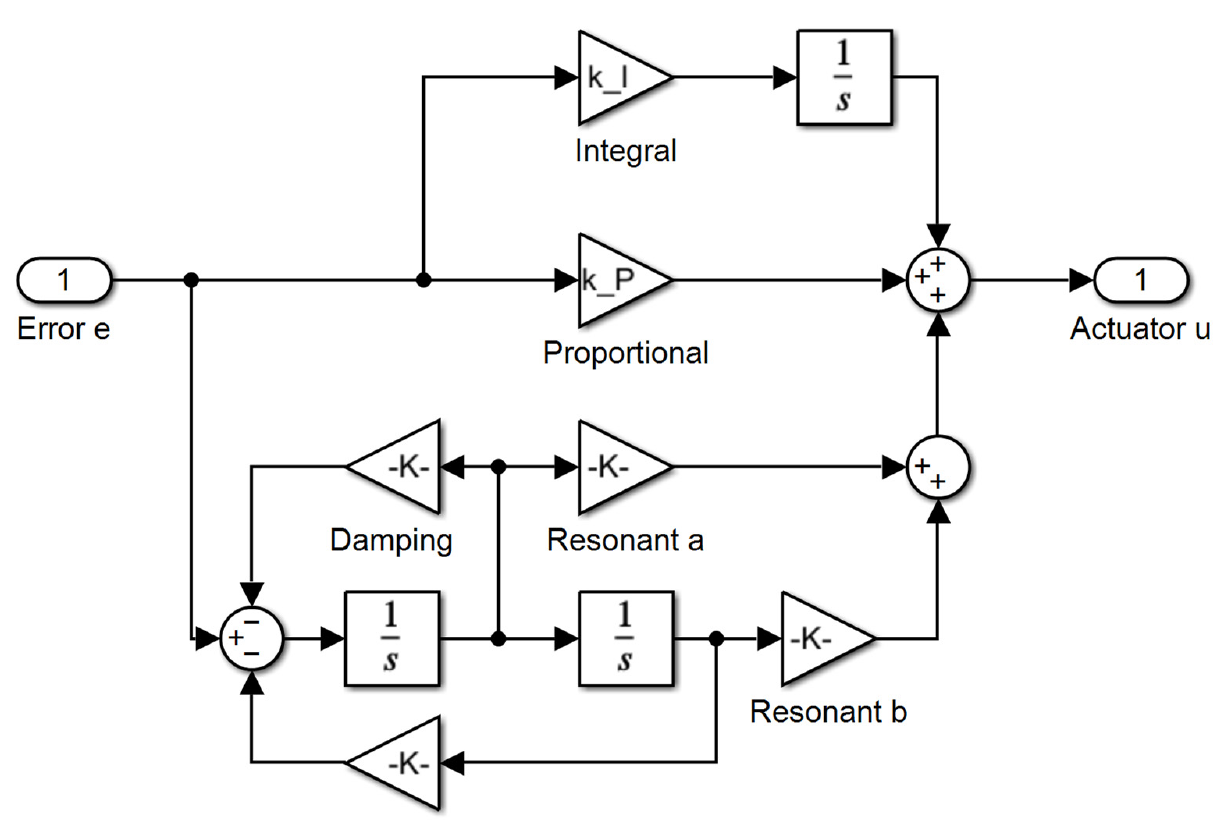
Figure 2. Structure of a PIR Controller.